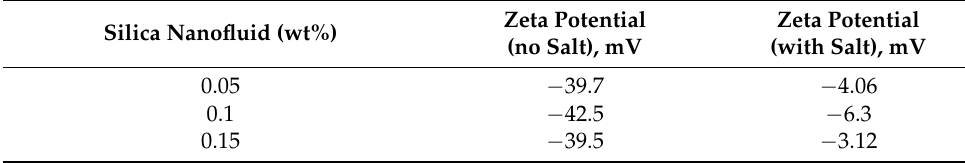
Table 7. Measured zeta